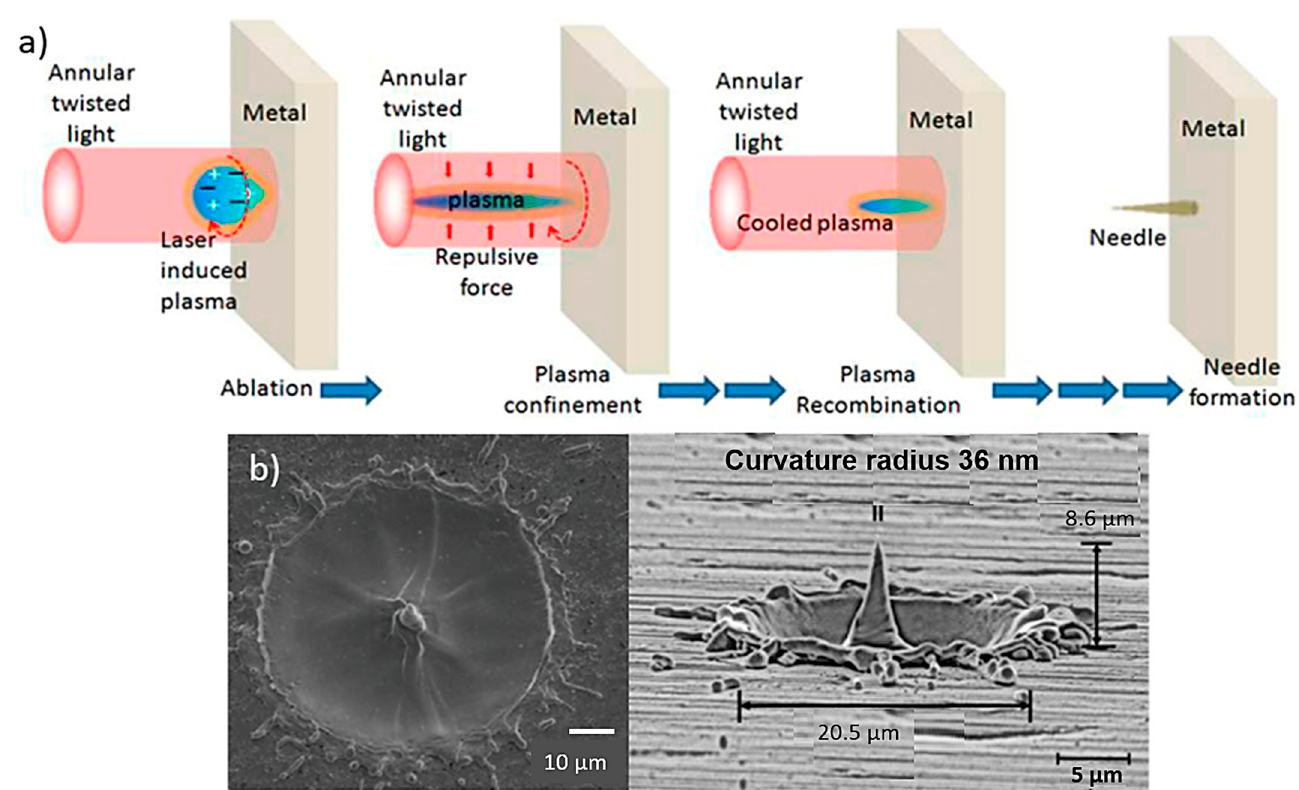
Figure 8. ( a ) Schematic for MN fabrication using light pulses that are able to give the suitable needle shape in the sheet [118], ( b ) produced metallic needles by the laser ablation technique with max height of 8.6 µm using three light pulses